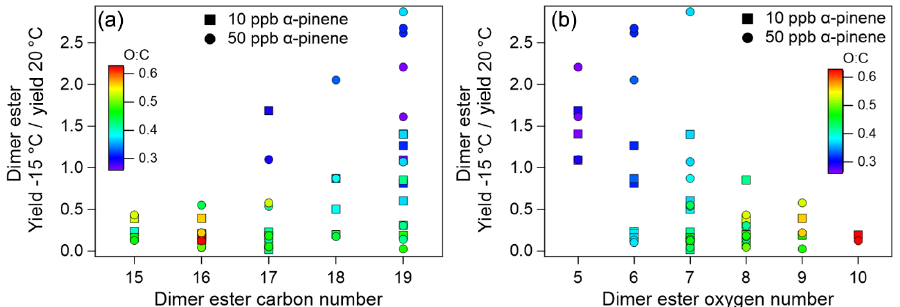
Figure 6. Comparison of relative yields (yield at − 15 ◦ C/yield at 20 ◦ C) for specific dimer esters as a function of dimer ester (a) carbon number and (b) oxygen number in 10 and 50ppb α -pinene ozonolysis experiments. Colour scale indicates the O : C ratio of the dimer esters.